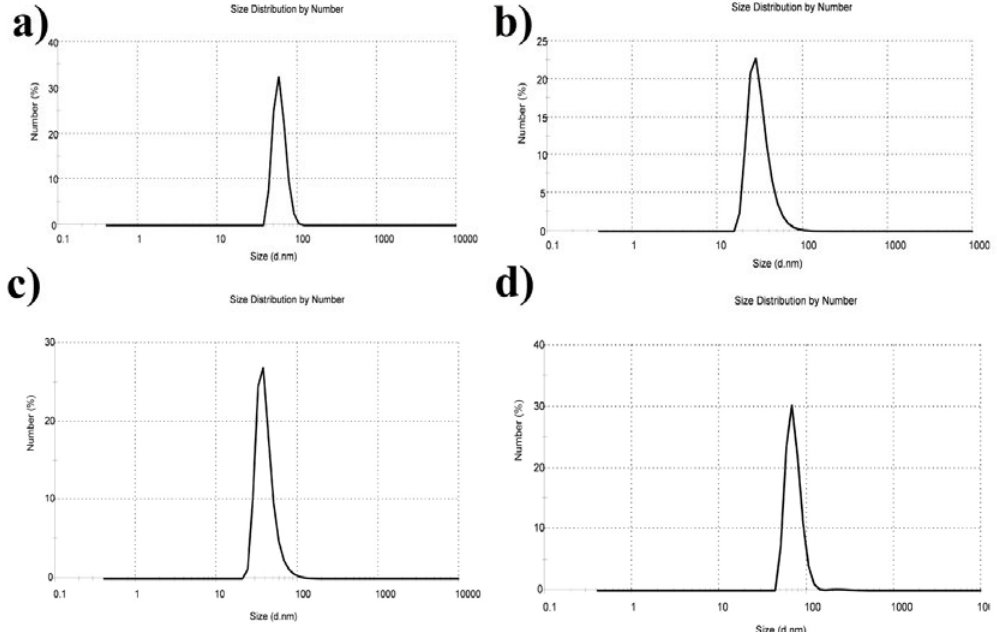
Fig. 1. DLS diagram of nanoemulsion a) (I), b) (II), c) (I) with chitosan, and d) (II) with